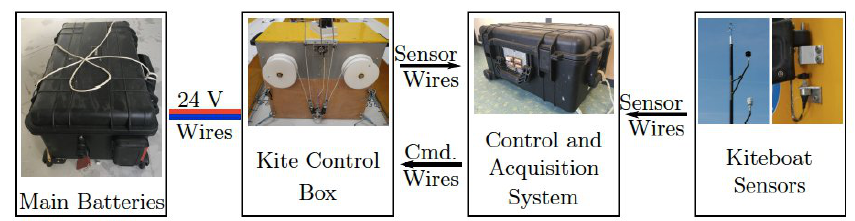
Figure 7. Overview of the experimental set-up when deployed on the